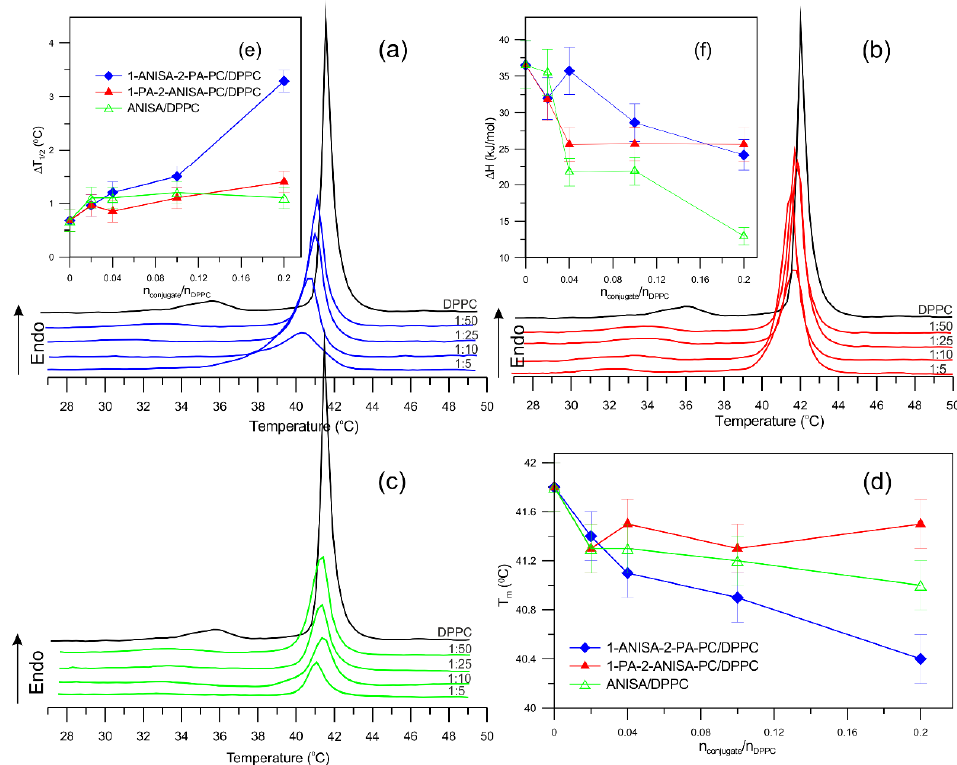
Figure 2. DSC thermogram of DPPC liposomes and new form of liposomes composed of DPPC and conjugates of anisic acid with phosphatidylcholine: ( a ) DPPC with 1-ANISA-2-PA-PC, ( b ) DPPC with 1-PA-2-ANISA-PC, and ( c ) DPPC with ANISA; ( d ) Main phase transition temperatures (T m ) as a function of concentration; ( e ) Half-width peak (ΔT 1/2 ) as a function of concentration; ( f ) Enthalpy change ( ∆ H) of the main phase transition as a function concentration ofcompounds. The conjugate:DPPC molar ratios 1:5 ; 1:10 ; 1:25; 1:50 .